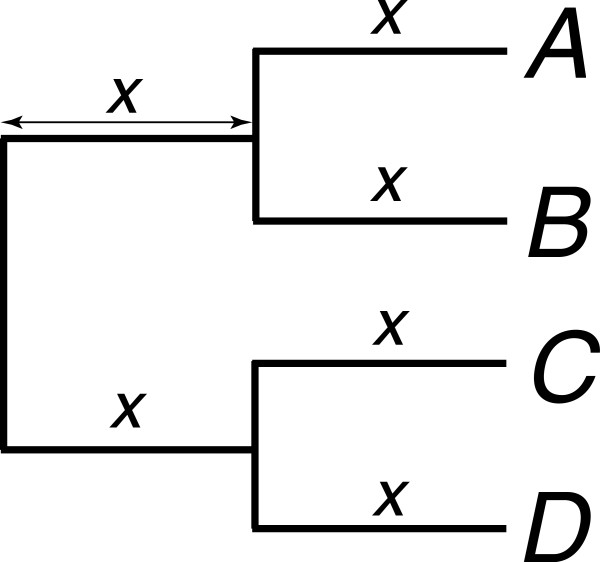
Tree topology used in the simulation of sequence data. The topology depicting the evolutionary relationship among sequences A, B, C and D in the simulated protein family; x represents the length of each internal branch (unit: number of substitutions per site).